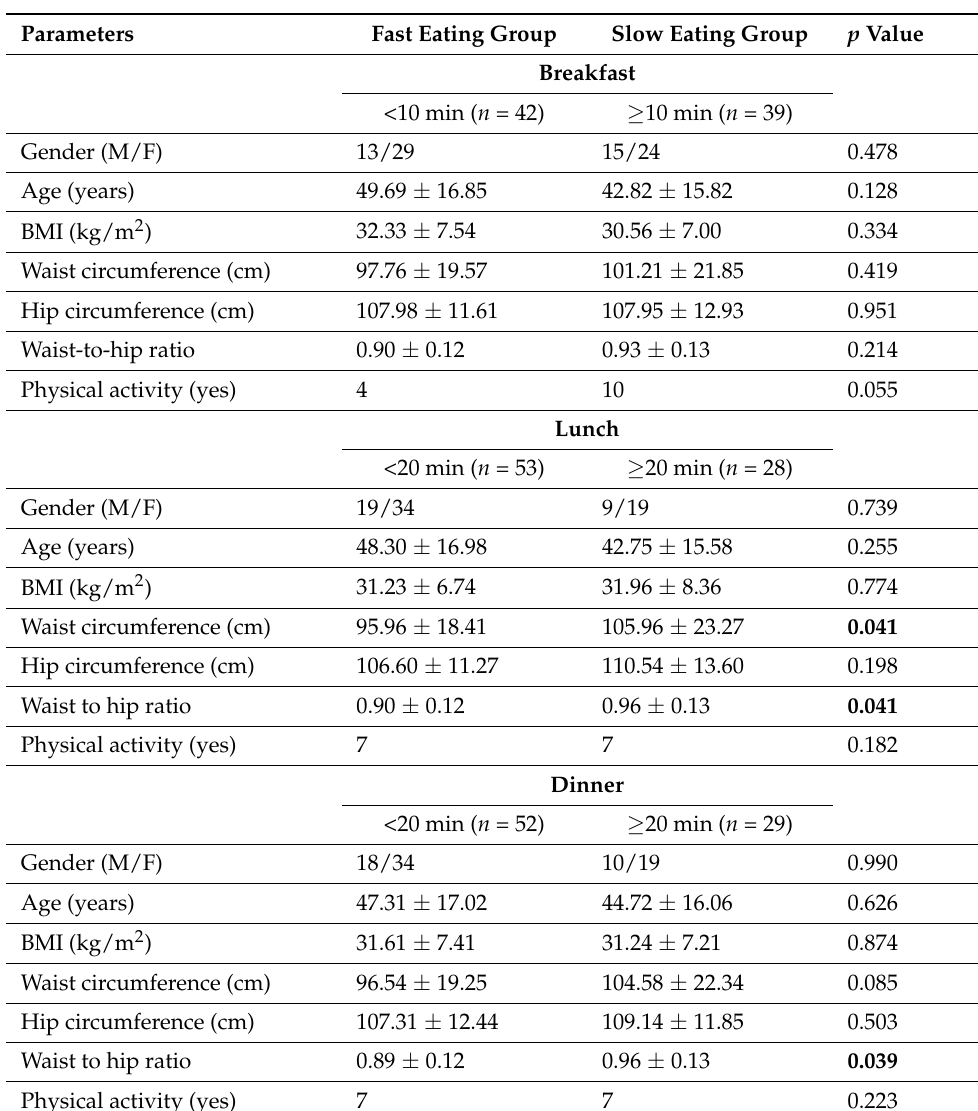
Table 2. Main characteristics of the study population according to eating speed. Parameters Fast Eating Group Slow Eating Group p